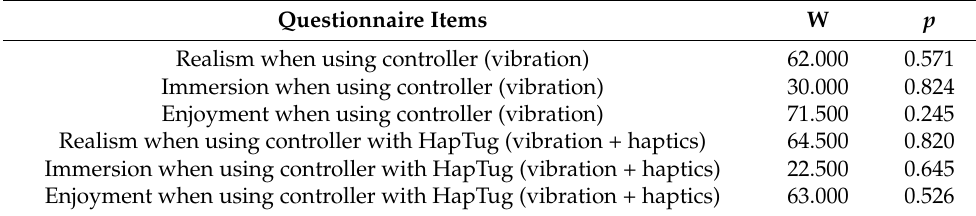
Table 3. Homogeneity test based on different sequential orders of experiments.